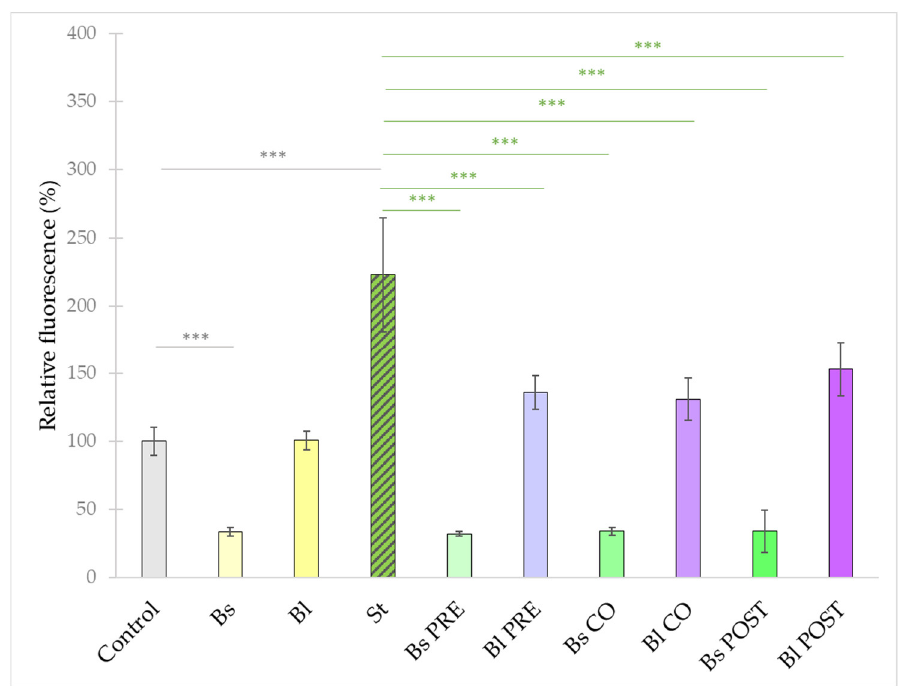
Figure 8. Amount of intracellular ROS after treatment with S. Typhimurium, B. licheniformis, and B. subtilis and their combinations. B. licheniformis and B. subtilis were added 1 h before (pre-treatment), at the same time as (co-treatment), or after (post-treatment) the addition of S. Typhimurium. Control : plain cell culture medium treatment; St : S. Typhimurium 10 6 CFU/mL; Bs : B. subtilis 10 8 CFU/mL; Bl : B. licheniformis 10 8 CFU/mL; Bs PRE : pre-treatment with B. subtilis 10 8 CFU/mL + S. Typhimurium 10 6 CFU/mL; Bl PRE : pre-treatment with B. licheniformis 10 8 CFU/mL + S. Typhimurium 10 6 CFU/mL; Bs CO : co-treatment with B. subtilis 10 8 CFU/mL + S. Typhimurium 10 6 CFU/mL; Bl CO : co-treatment with B. licheniformis 10 8 CFU/mL + S. Typhimurium 10 6 CFU/mL; Bs POST : post-treatment with B. subtilis 10 8 CFU/mL + S. Typhimurium 10 6 CFU/mL; Bl POST : post- treatment with B. licheniformis 10 8 CFU/mL + S. Typhimurium 10 6 CFU/mL. Data are shown as means with standard deviations and expressed as relative fluorescence, considering the mean value of control as 100%. n = 6/group. Significant difference: *** p ≤ 0.0001, in grey: compared with the untreated control. *** p ≤ 0.0001, in green: compared with treatment with S. Typhimurium. Treatment with E. coli caused an increase in the fluorescence compared with the con- trol (Figure 9). Pre-, co-, and post-treatment with both probiotic bacteria significantly re- duced the amount of reactive oxygen species in the cells compared with samples only treated with E. coli .